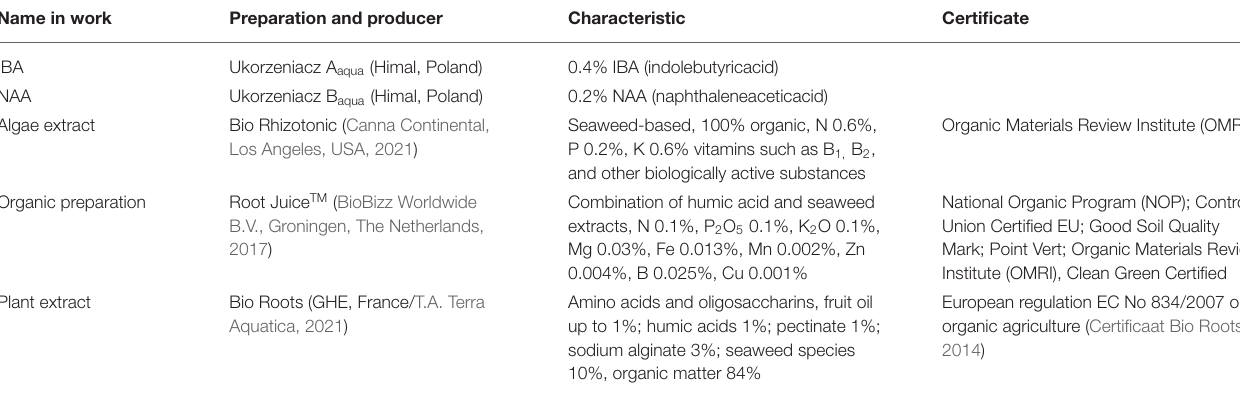
TABLE 1 | Rooting enhancers used in the rooting of Rosa